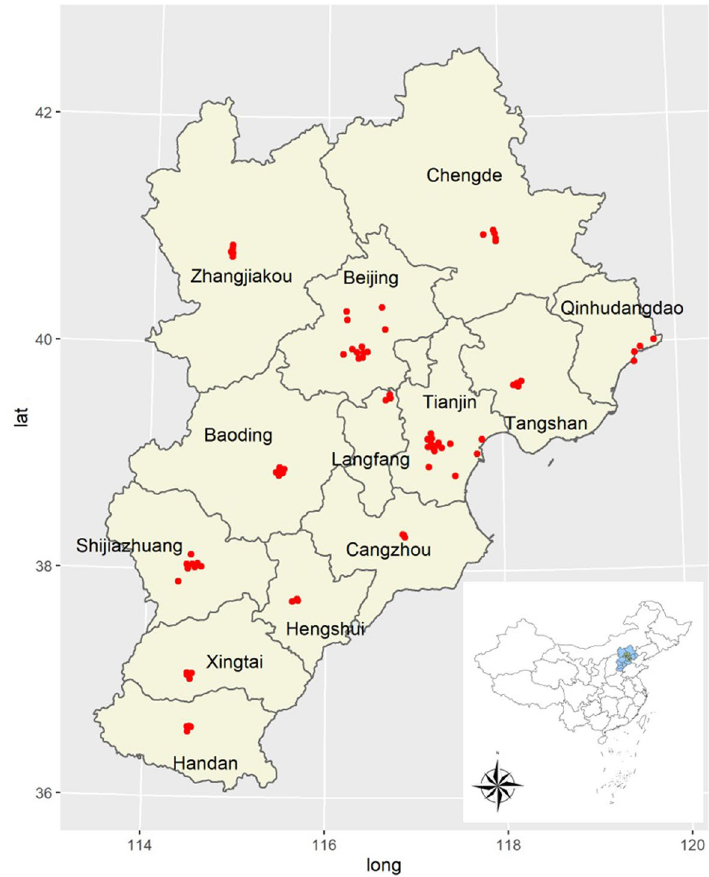
Figure 4. Geographical locations of air pollutant monitoring stations in the Jing-Jin-Ji region. The maps were drawn with R package ggplot2 version 3.3.3, https:// ggplo t2. tidyv erse.